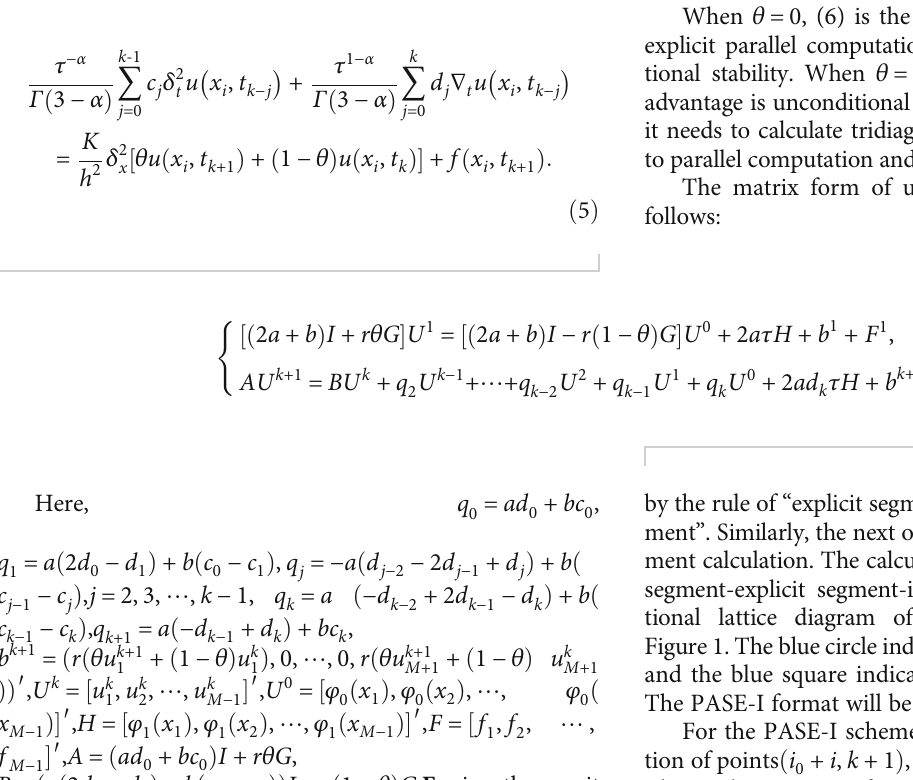
Figure 1. The blue circle indicates the classical explicit scheme, and the blue square indicates the classical implicit scheme.